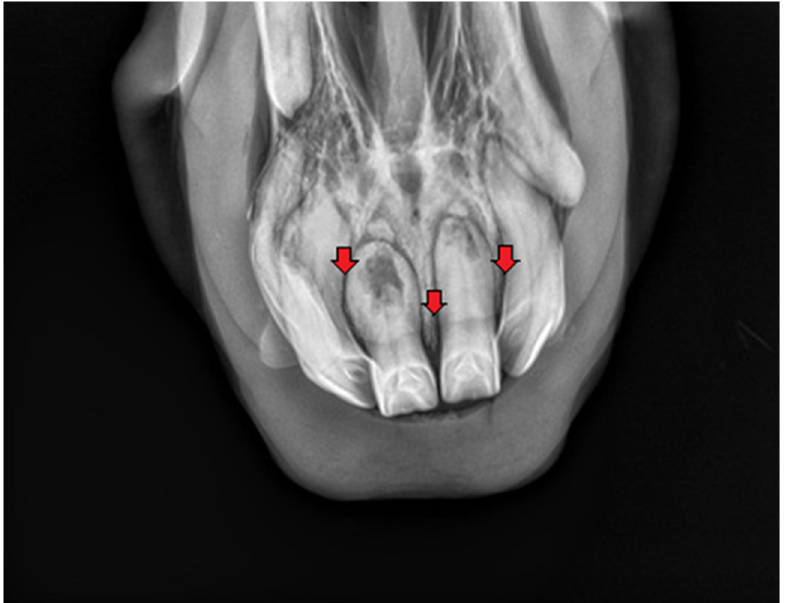
Figure 7. Case 2—intraoral radiograph of maxillary incisor teeth. Bulbous enlargement of the intra ‐ alveolar part of the teeth, widening of periodontal ligament space (red arrows).